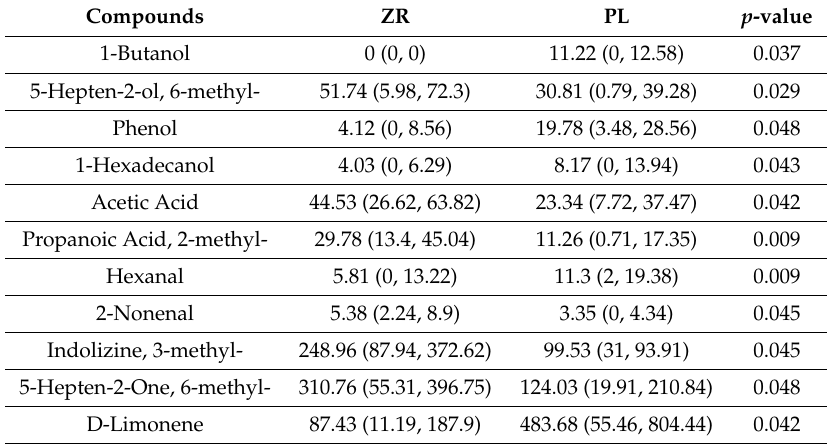
Table 2. Volatile organic compounds (VOCs). Concentration (min, max) of VOCs (ppm) headspace fecal samples of treated (ZR) and placebo (PL) patients.